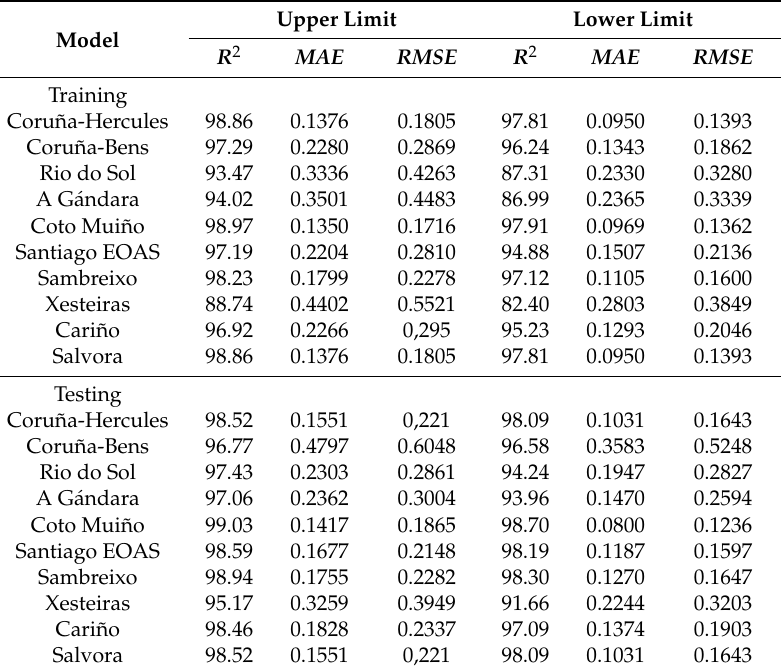
Table 10. Results of the training and testing of the MLP models of approach